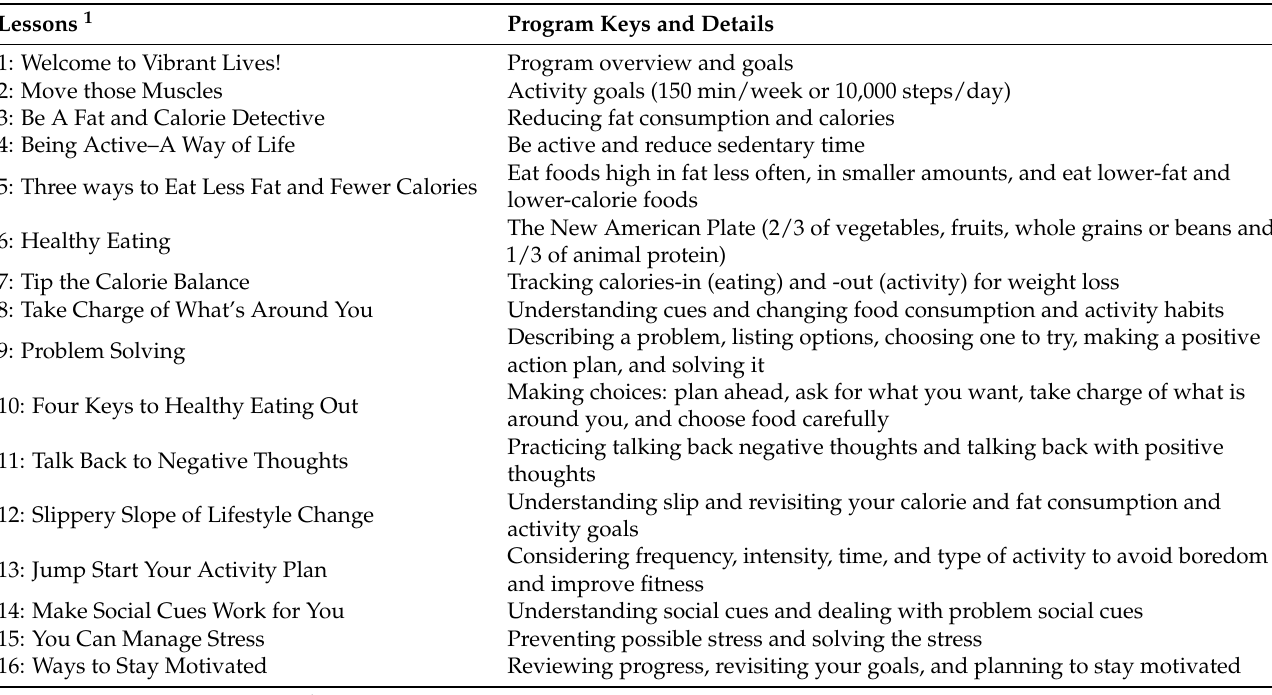
Table 1. Adapted Diabetes Prevention Program (DPP)